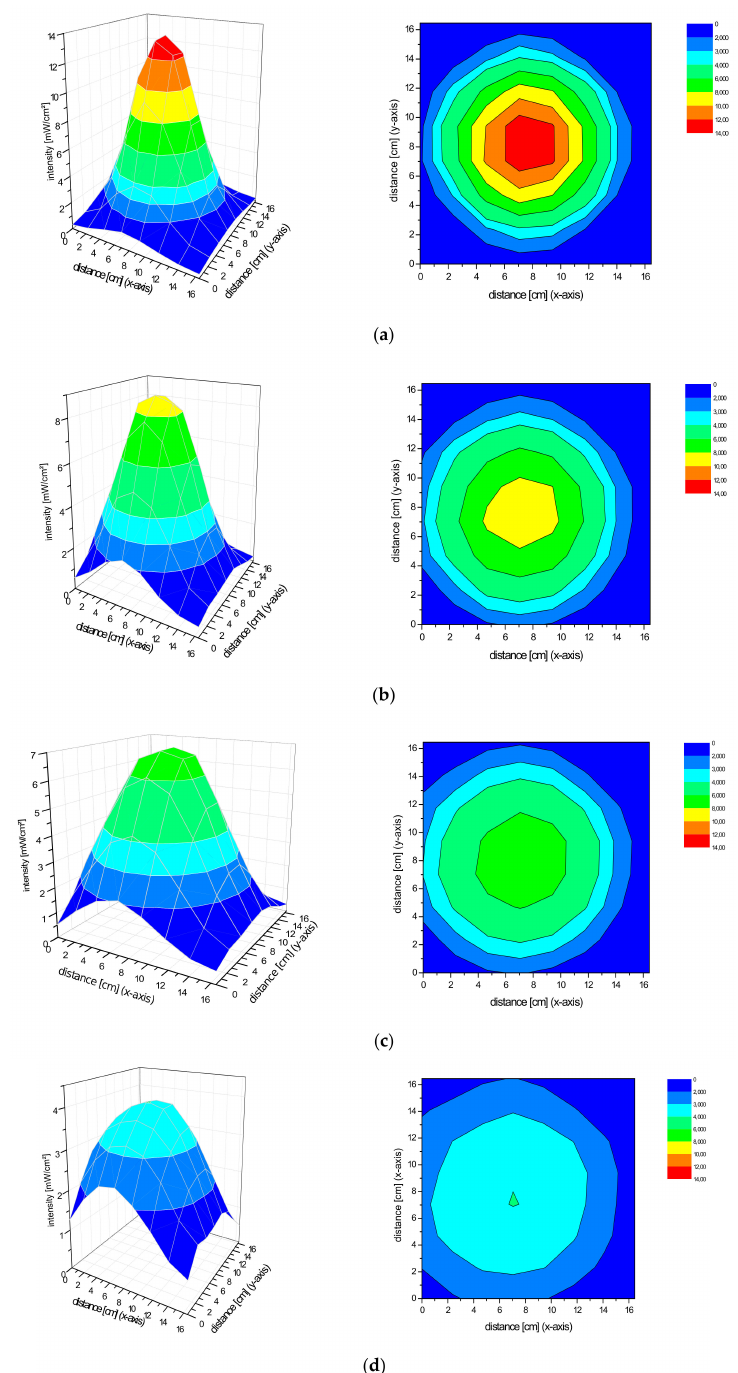
Figure 4. ( a ) Irradiance distribution of the Repuls7PDI-blue at a distance of 10 cm. The device was fixed with a tripod with the radiating surface parallel downwards to the measuring plane. ( b ) Irradiance distribution of the Repuls7PDI-blue at a distance of 13.5 cm. The device was fixed with a tripod with the radiating surface parallel downwards to the measuring plane. ( c ) Irradiance distribution of the Repuls7PDI-blue at a distance of 15 cm. The device was fixed with a tripod with the radiating surface parallel downwards to the measuring plane. ( d ) Irradiance distribution of the Repuls7PDI-blue at a distance of 20 cm. The device was fixed with a tripod with the radiating surface parallel downwards to the measuring